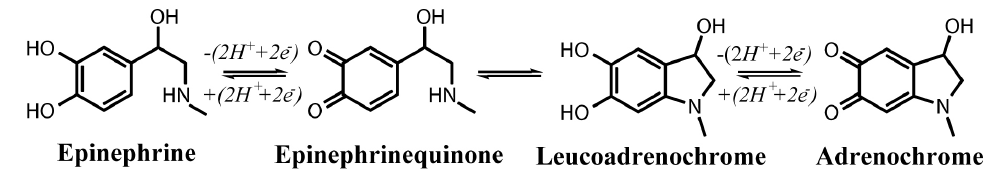
Figure 5. The possible mechanism for electrochemical oxidation of epinephrine [45].